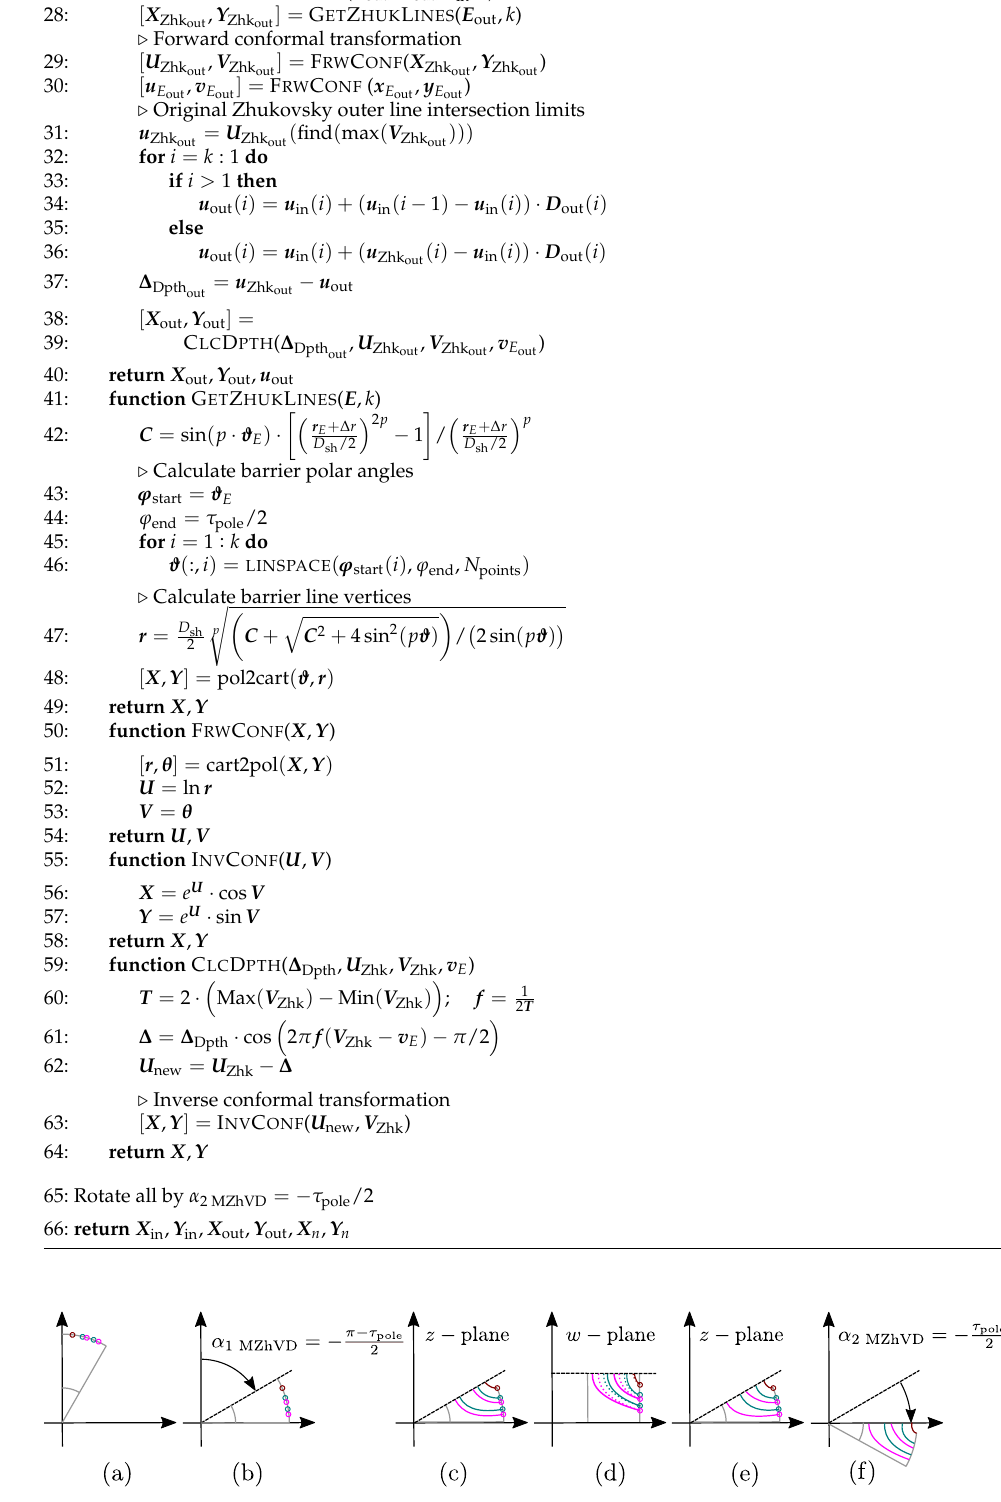
Figure 12. Modified Zhukovsky barrier construction and rotation steps. Subigures ( a )–( f ) are ex- plained within the Sections